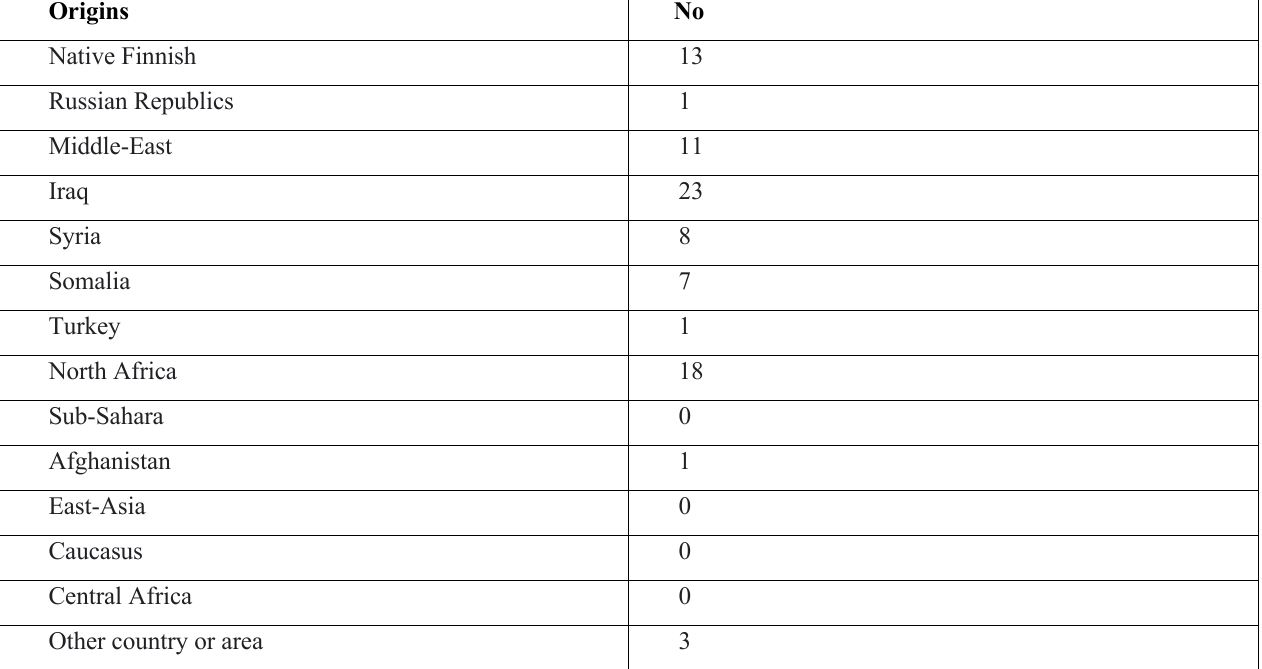
Table 1. The origin of the